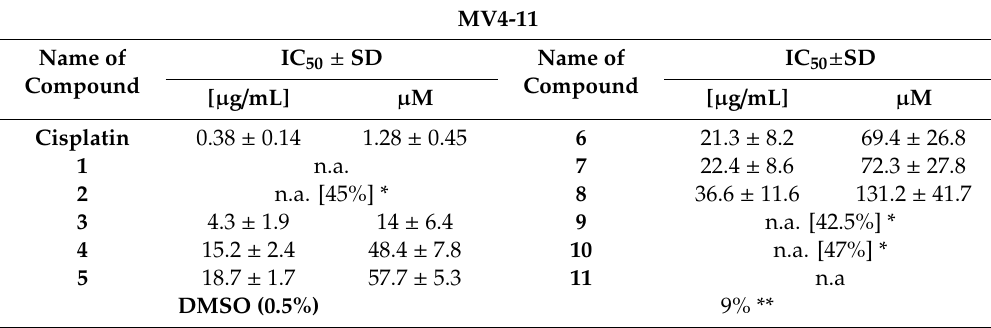
Table 1. Results of examination of IC 50 of the all obtained compounds against the human biphenotypic B cell myelomonocytic leukemia (MV4-11).